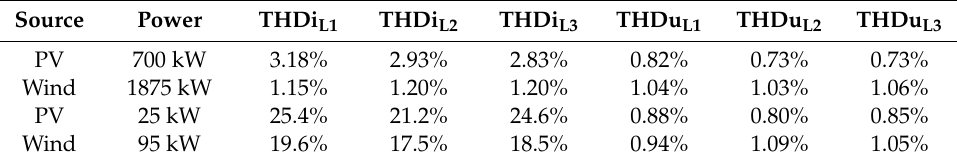
Table 4. THD coe ffi cients for di ff erent power